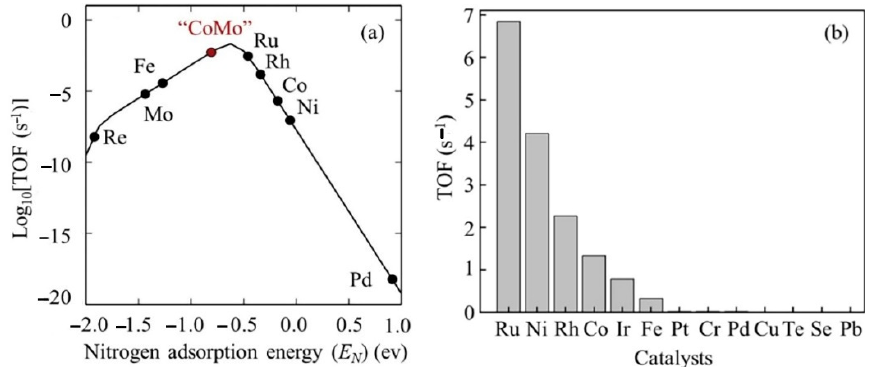
Figure 28. Turnover frequency (TOF) ( a ) as a function of nitrogen adsorption and ( b ) of various precious metal catalysts. Reprinted with permission [48].